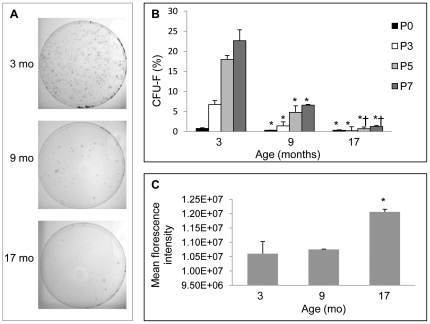
Comparison of the prevalence of colony forming fibroblasts (CFU-F) in the lung of 3, 9 and 17 month old mice.
A. Examples of representative CFU-F plates derived from 3, 9 and 17 month old mice at passage 5. B. Comparison of passages 0 (primary digest), 3, 5, and 7 CFU-F derived from 3, 9 and 17 month old mice. *P<0.05 compared to same passage fibroblasts from 3 month old donor mice; † P<0.05 17 months vs. 9 months same passage fibroblasts; n = 3 experiments/time point. C. Comparison of mean florescence intensity obtained by flow cytometry as a measure of cell size between 3, 9 and 17 month cultured lung fibroblasts (passage 4). Cells were gated on forward and side-scatter and 7AAD (negative), and then analyzed for forward scatter mean (30,000 independent events). *P<0.05 compared to fibroblasts from 3 month old mice.